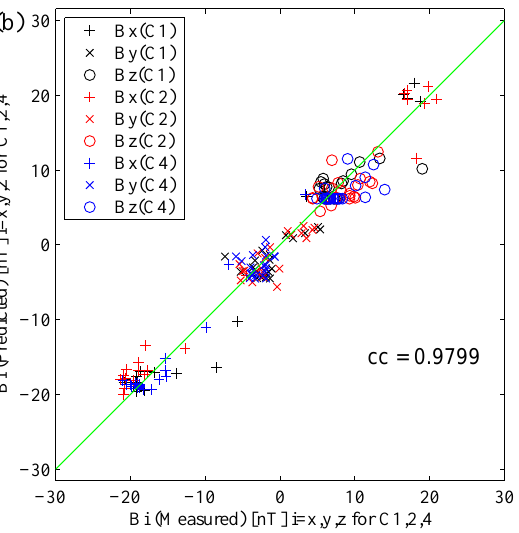
Fig. 6. (a) Time series of the measured (solid) and predicted (dashed) magnetic field data. The predicted data are based on the field map reconstructed from C3 data (Fig. 5). (b) Correlation be- tween the measured and predicted magnetic field data. The format is the same as in Fig. 4.